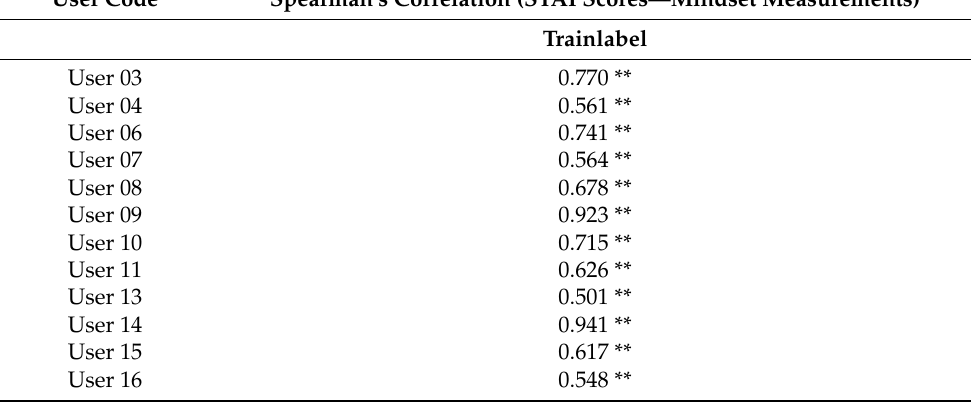
Table 3. Significant correlation coefficients between the STAI score and Mindset measurements for each